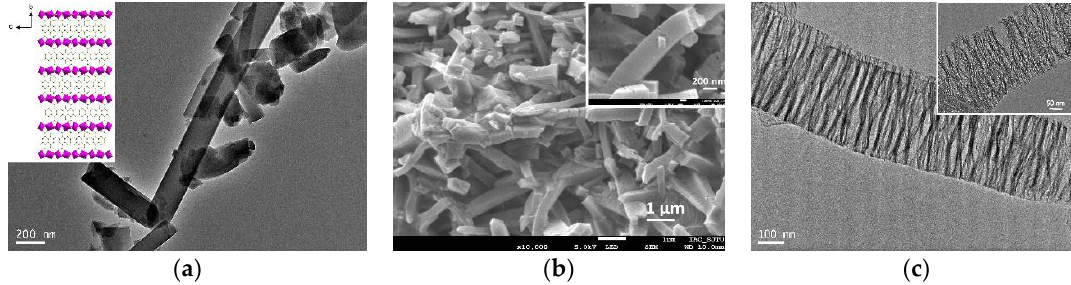
Figure 2. TEM images of ( a ) Al-MOFs precursor, insert is the structure of Al-MOFs (Al-1,4-NDC), ( b ) SEM images and ( c ) TEM images of obtained Al 2 O 3 -Spongy by two-step pyrolysis of Al-NDC, inset is the magnified TEM and SEM images of Al 2 O 3 -Spongy.